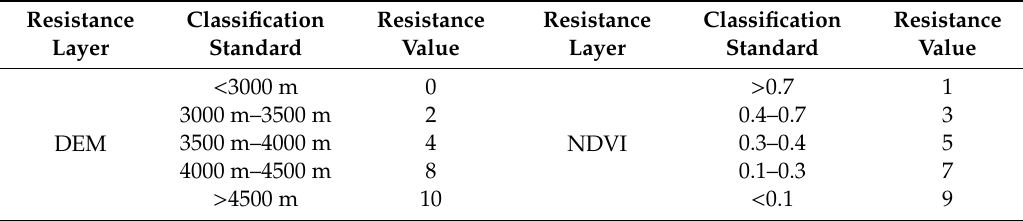
Table 4. Resistance assignment for natural